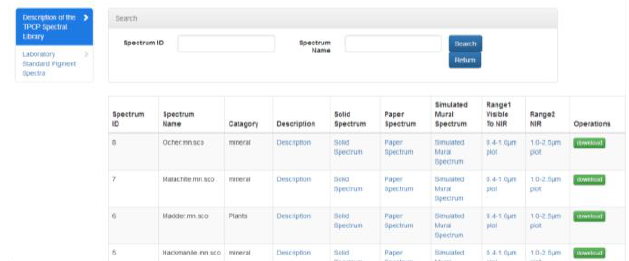
Figure 8. The module interface of TPCP spectral